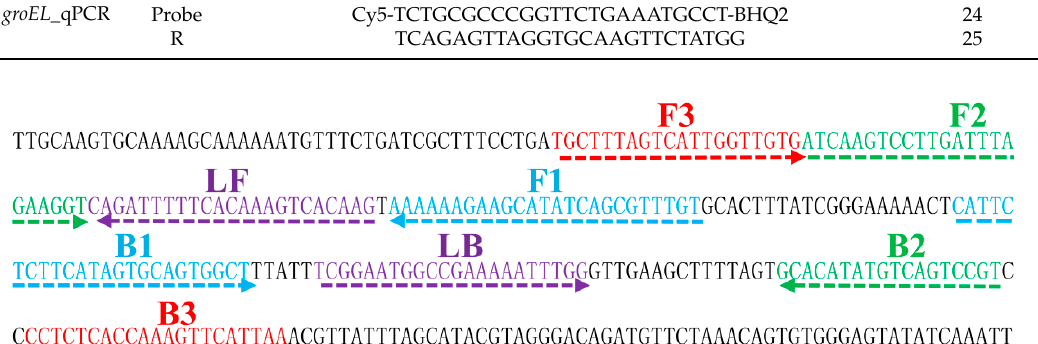
Figure 6. Location and sequences of B. quintana groEL (str. Toulouse) gene used to design the six primers. The sequences of the primer sites are underlined. Right and left arrows indicate sense and complementary sequences that are used.